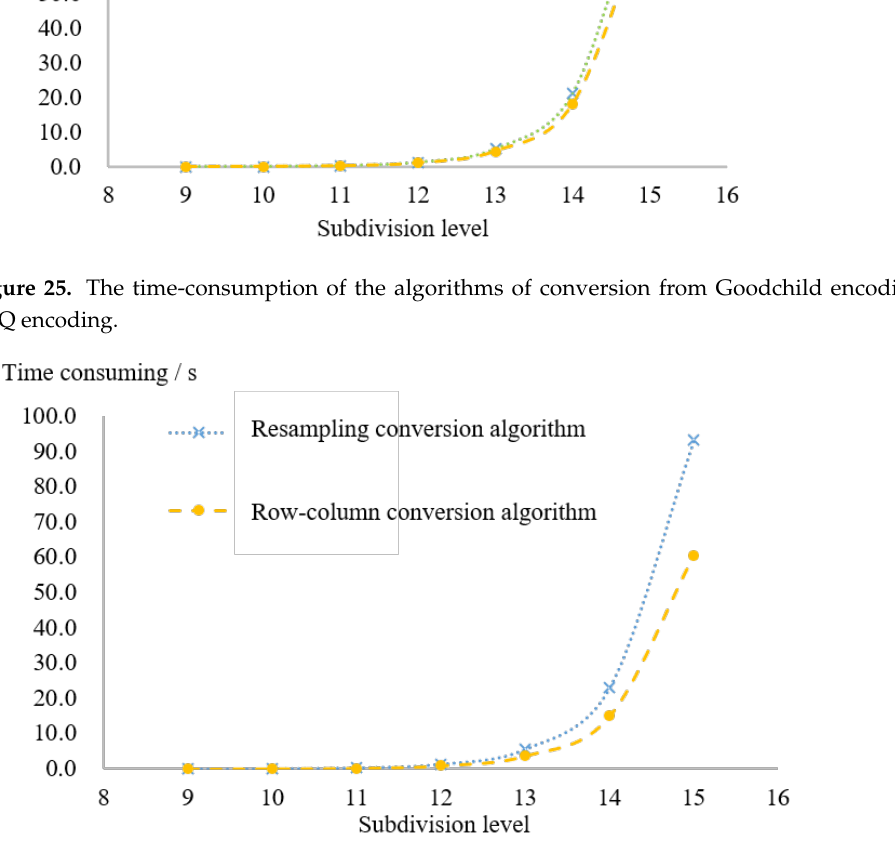
Figure 26. The time-consumption of the algorithms of conversion from TRQ encoding to Good- child encoding.